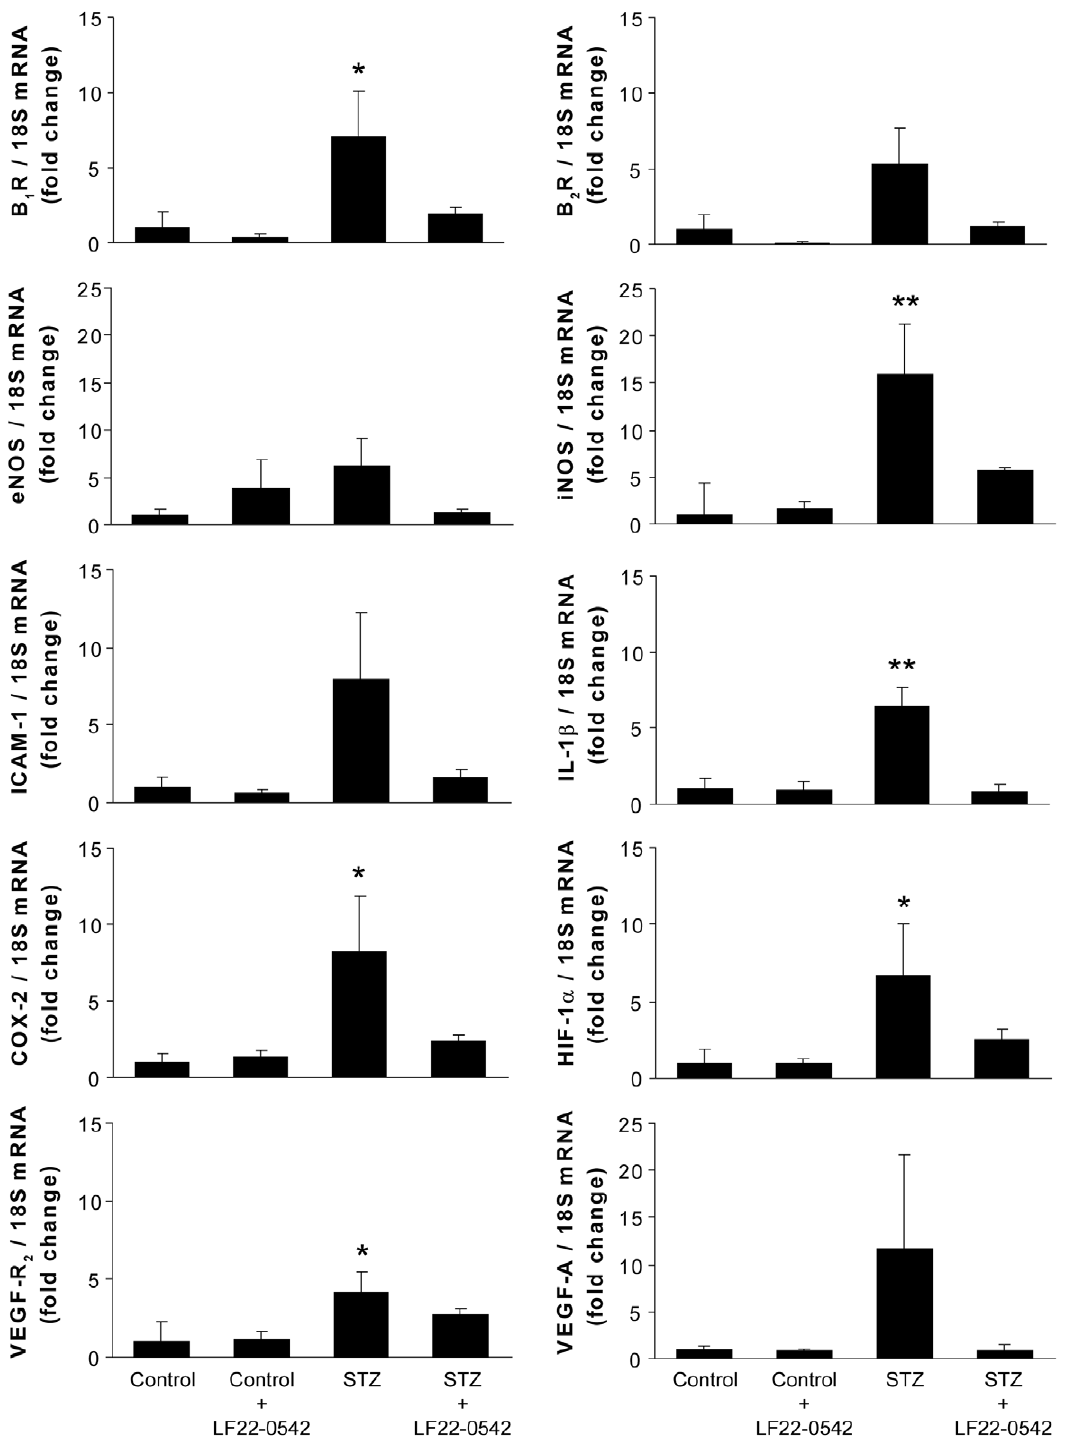
Figure 4. Effect of LF22-0542 on the expression of retinal inflammatory mediators in STZ-diabetic rats. mRNA levels of B 1 R, B 2 R, eNOS, iNOS, ICAM-1, IL-1 b , COX-2, HIF-1 a ,VEGF-R 2 and VEGF-A. Data are mean 6 s.e.m. of values obtained from 7–8 rats in each group. Statistical comparison with control rats (*) is indicated by *P , 0.05, **P , 0.01.